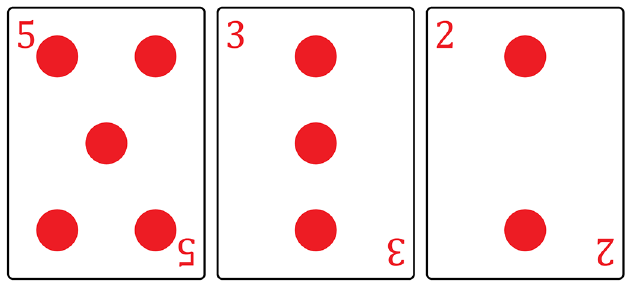
Figure 1. Numerical cards used in War and Memory games; quantities ranged from 1 to